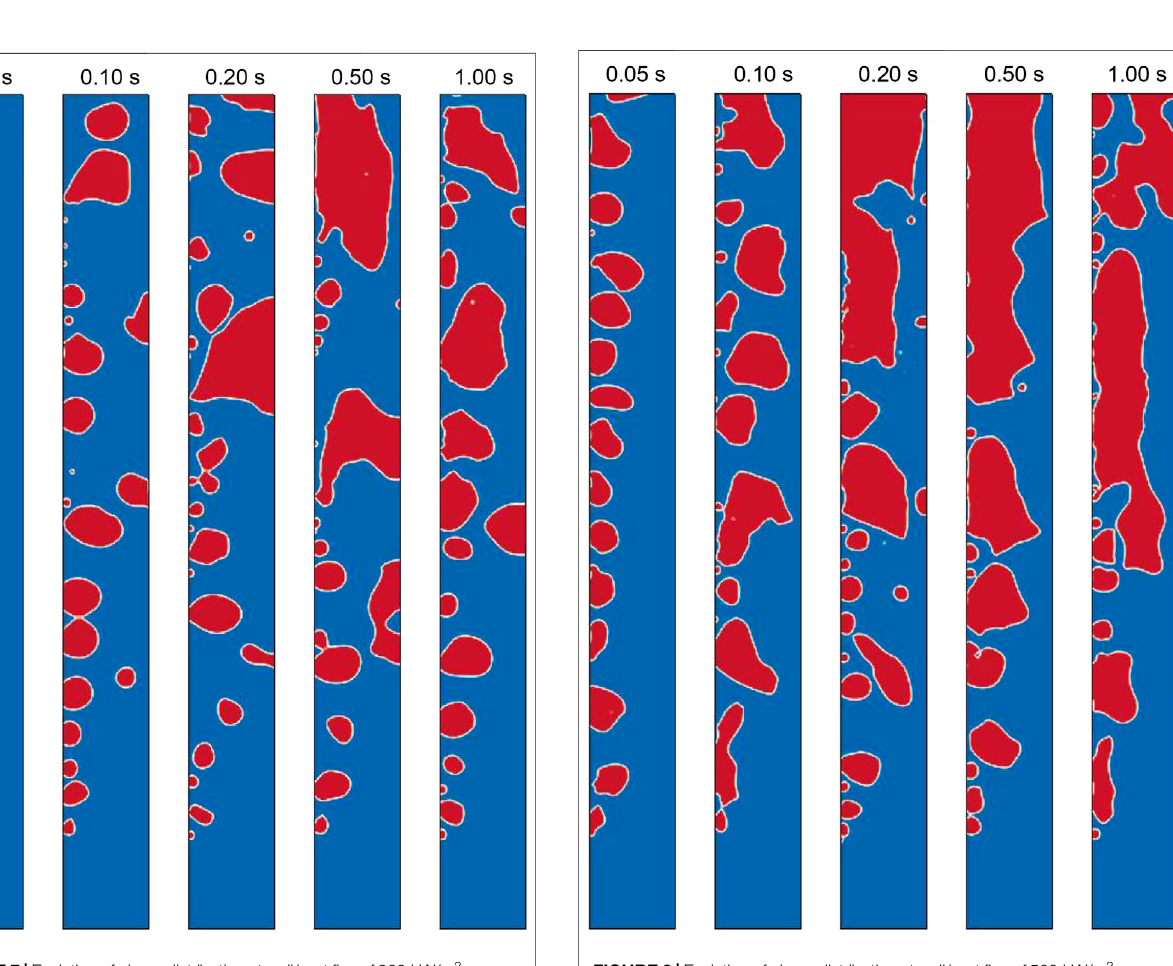
Frontiers in Energy Research |